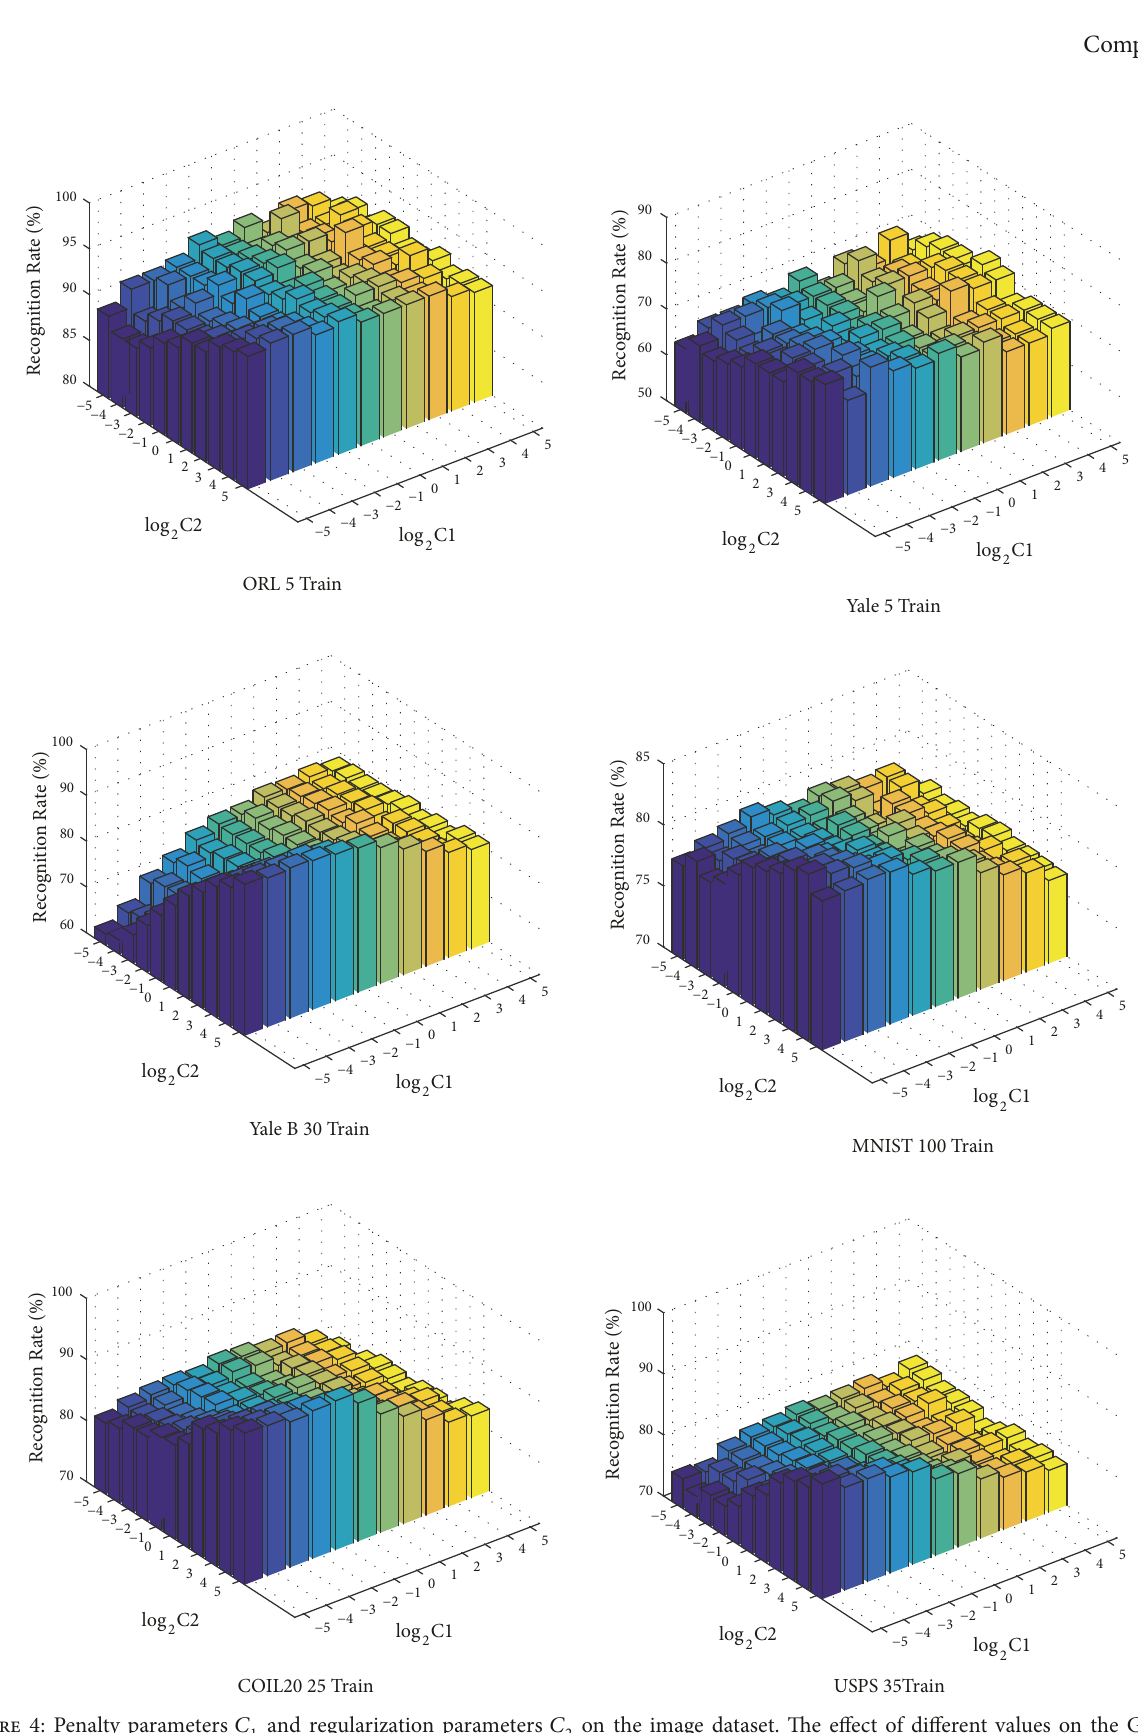
Figure 4: Penalty parameters 𝐶 1 and regularization parameters 𝐶 2 on the image dataset. The effect of different values on the GELLM algorithm, ORL, Yale, Yale B, COIL20, MNIST, and